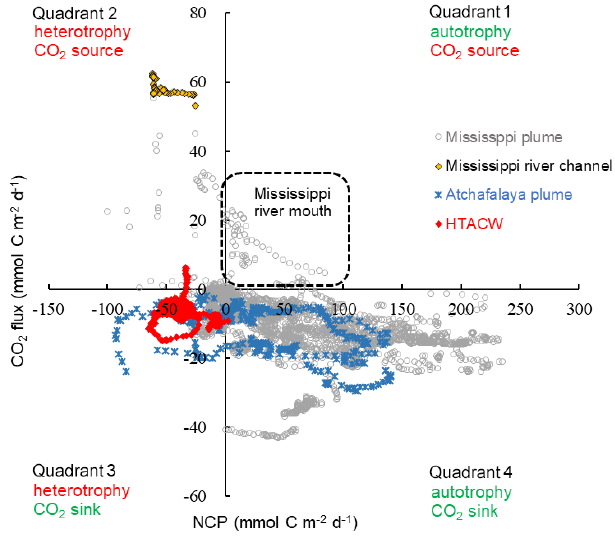
Figure 10. Scatter plot of NCP O surface water of the nGOM. Positive NCP implies net autotrophy and negative CO 2 flux implies net oceanic CO 2 uptake from the